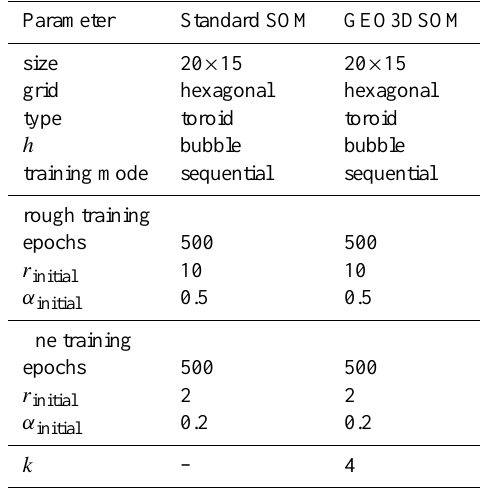
Table 4. Parameters of SOM and